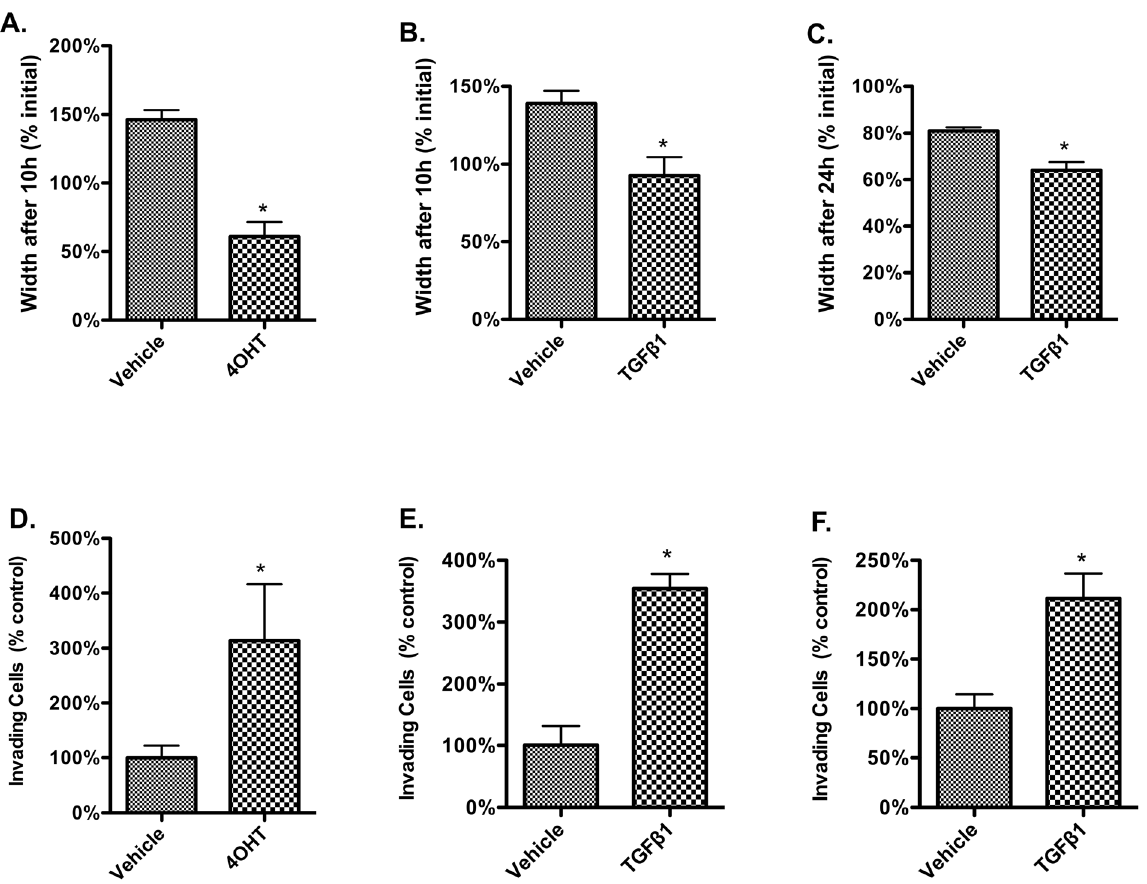
Figure 2. Functional increase in migration and invasion following treatment to induce EMT in three cell-based models of breast cancer. Changes in cell behavior were seen by Day 4 in HMLE Twist ER cells and by Day 2 in MCF-7 cells. Top panels: Migration assayed by scratch- wound assay. Bottom panels: Invasion in a modified Boyden-chamber invasion assay. A. Closure of a scratch wound after 10 h in vehicle control versus HMLE Twist ER cells treated with 4OHT (induced Twist model). B. Closure of a scratch wound after 10h in vehicle control versus HMLE Twist ER cells treated with TGF- b 1. C. Closure of a scratch wound after 24 h in vehicle control versus MCF-7 cells treated with TGF- b 1. Due to inherent differences in cell biology, the rate of migration was faster for HMLE Twist ER cells treated with 4OHT or TGF- b 1 than for MCF-7 cells treated with